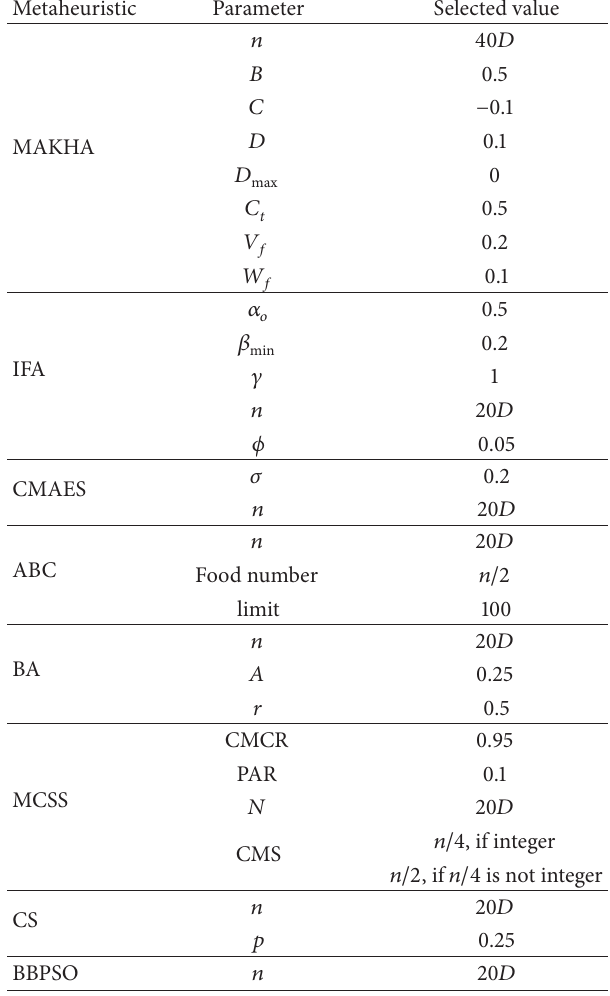
Table 3: Selected values of the parameters used in the implementa- tion of the eight nature-inspired metaheuristic algorithms. Metaheuristic